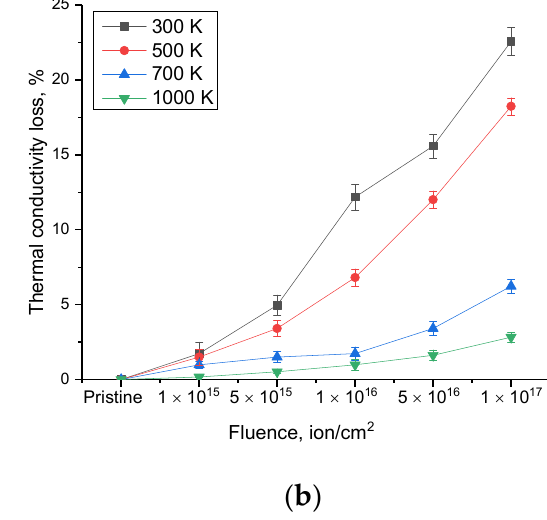
Figure 8. ( a ) Results of changes in the thermal conductivity of ceramics depending on the irradiation conditions; ( b ) Results of thermal conductivity losses depending on the irradiation conditions.